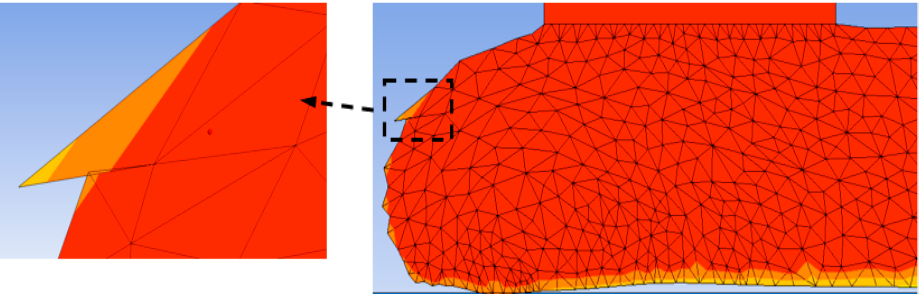
Figure 7. Element distortion in deposited melt after remeshing with the element quality value of T quality = 0.5.